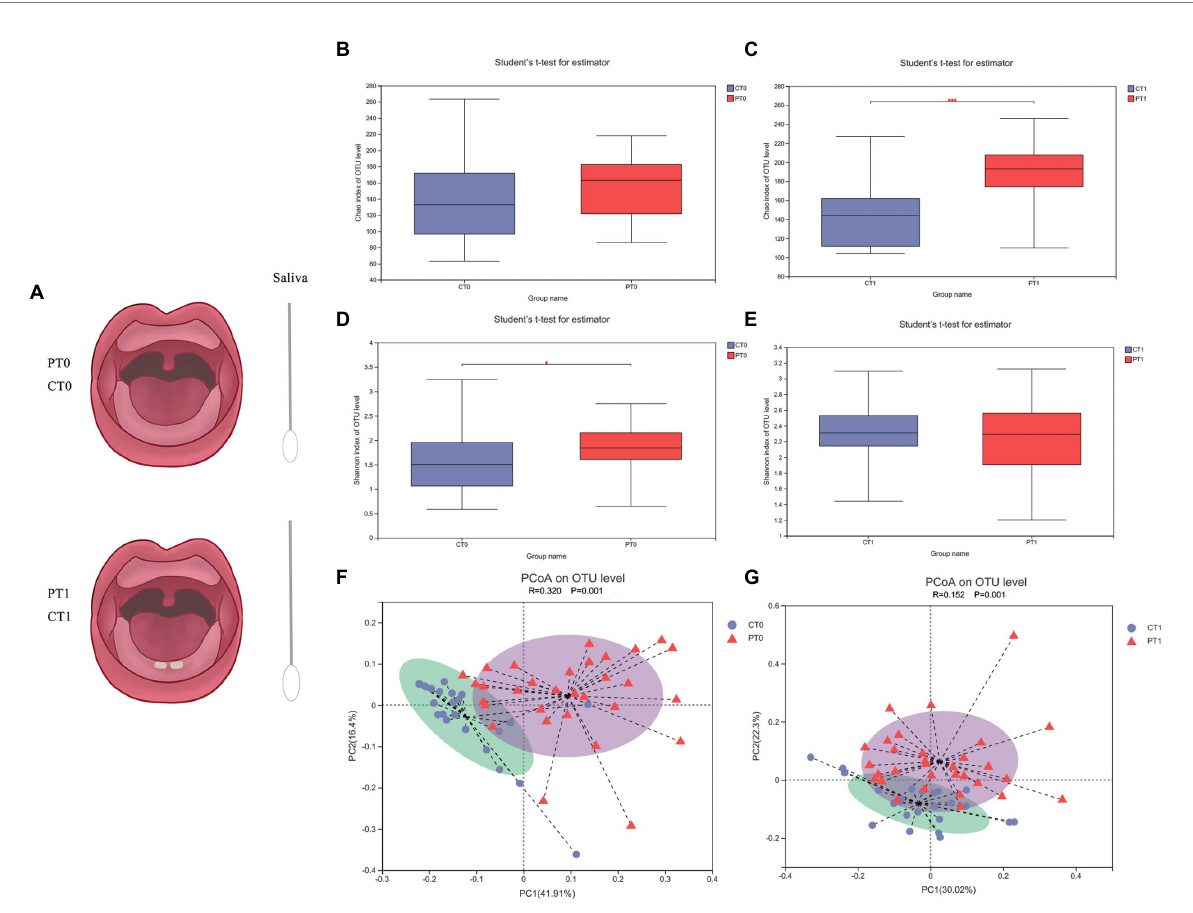
FIGURE 1 Flow chat and species diversity of microbiota in saliva samples of infants differ in preterm infants. (A) Flow chat of this study. (B–E) Bacterial richness and diversity (shown by Chao and Shannon indices), acquired at varying time points from the age of 1 month to teeth eruption, were identified using 16S rRNA Illumina sequencing together with OTU clustering at 97% concentration of sequence identity. * p < 0.05, *** p < 0.001. ( F,G) PCoA of the weighted normalized UniFrac distance observed at OTU level for the bacterial community structure of the saliva microbiome between the healthy and preterm groups at two